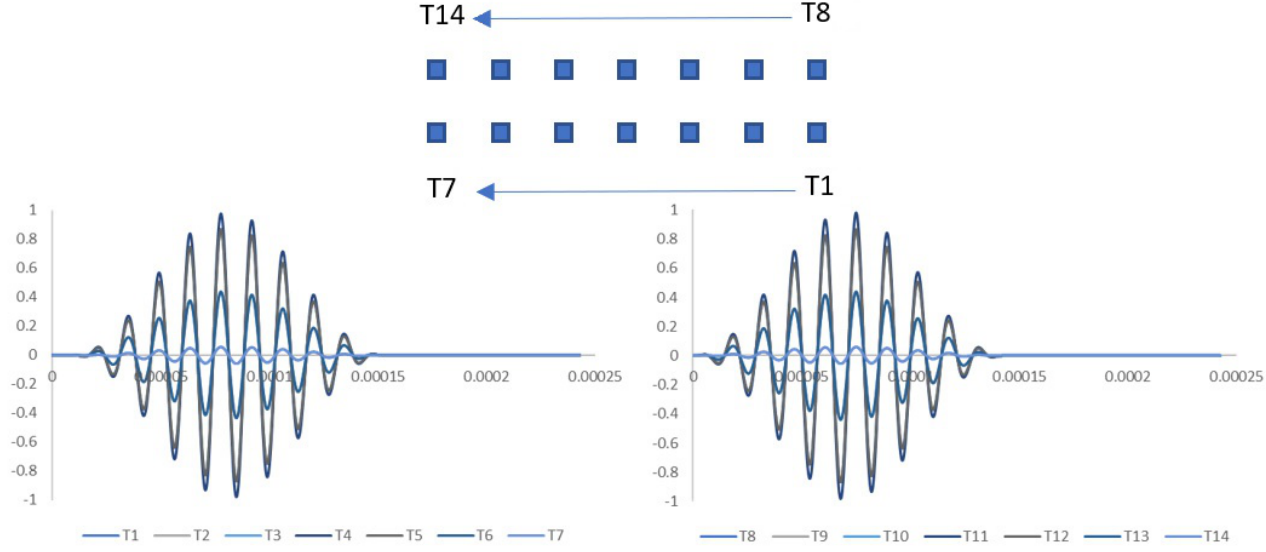
Figure 11. Apodisation of the amplitude of the excitation signal applied across each row of 7 × 2 array transduction points.